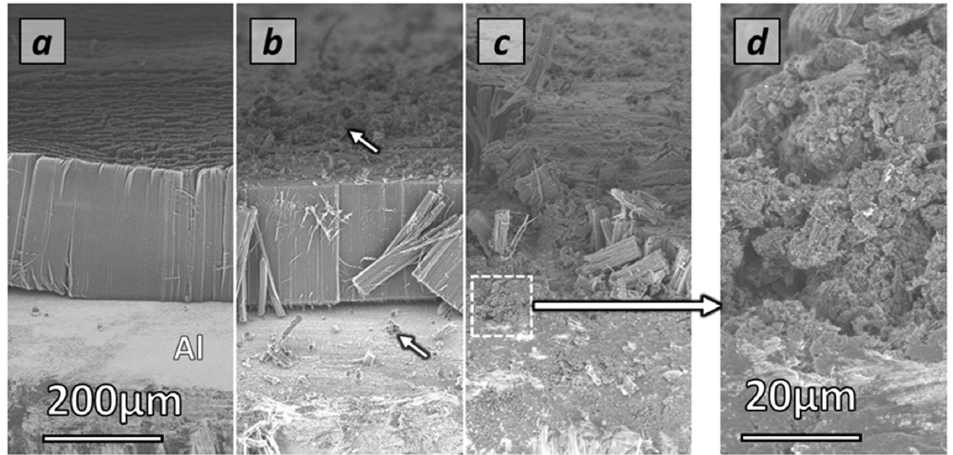
Figure 2. SEM micrographs on the exposed face showing: ( a ) typical homogeneous and clean VACNT carpet (low acetylene content, short synthesis duration); ( b ) typical homogeneous and unclean VACNT carpet (high acetylene content, long synthesis duration) showing carbon additional morphologies (see arrows) above and under the carpet; ( c ) typical inhomogeneous VACNT carpet showing a huge quantity of carbon by-products under the carpet (high acetylene content, long synthesis duration); ( d ) High magnification micrograph of carbon by-products observed in the white square area drawn on ( c ) micrograph (see arrow) and showing agglomerates of carbon particles. High magnification SEM observations of clean VACNT carpets, obtained from most of the synthesis conditions, indicate that the CNTs are well aligned and densely packed (Figure 3a–c). Individual CNT morphology, diameter and structure determined by TEM, indicate the formation of multi-walled CNTs (MWNTs) whose mean external diameters are in the [6–12] nm range, whatever the synthesis conditions (Figure 3d,e).